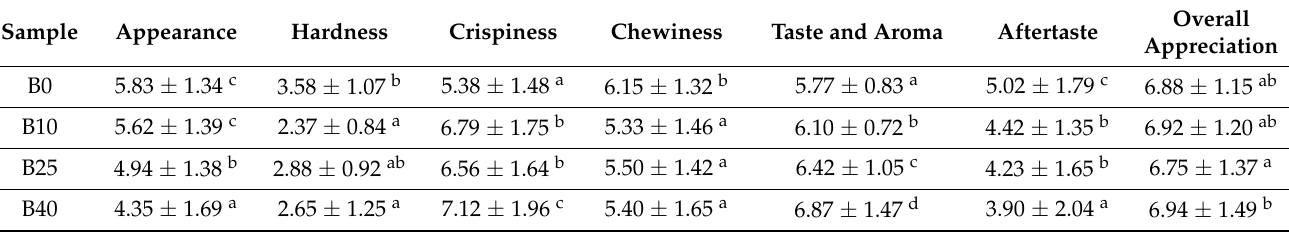
Table 9. Sensory evaluation of the